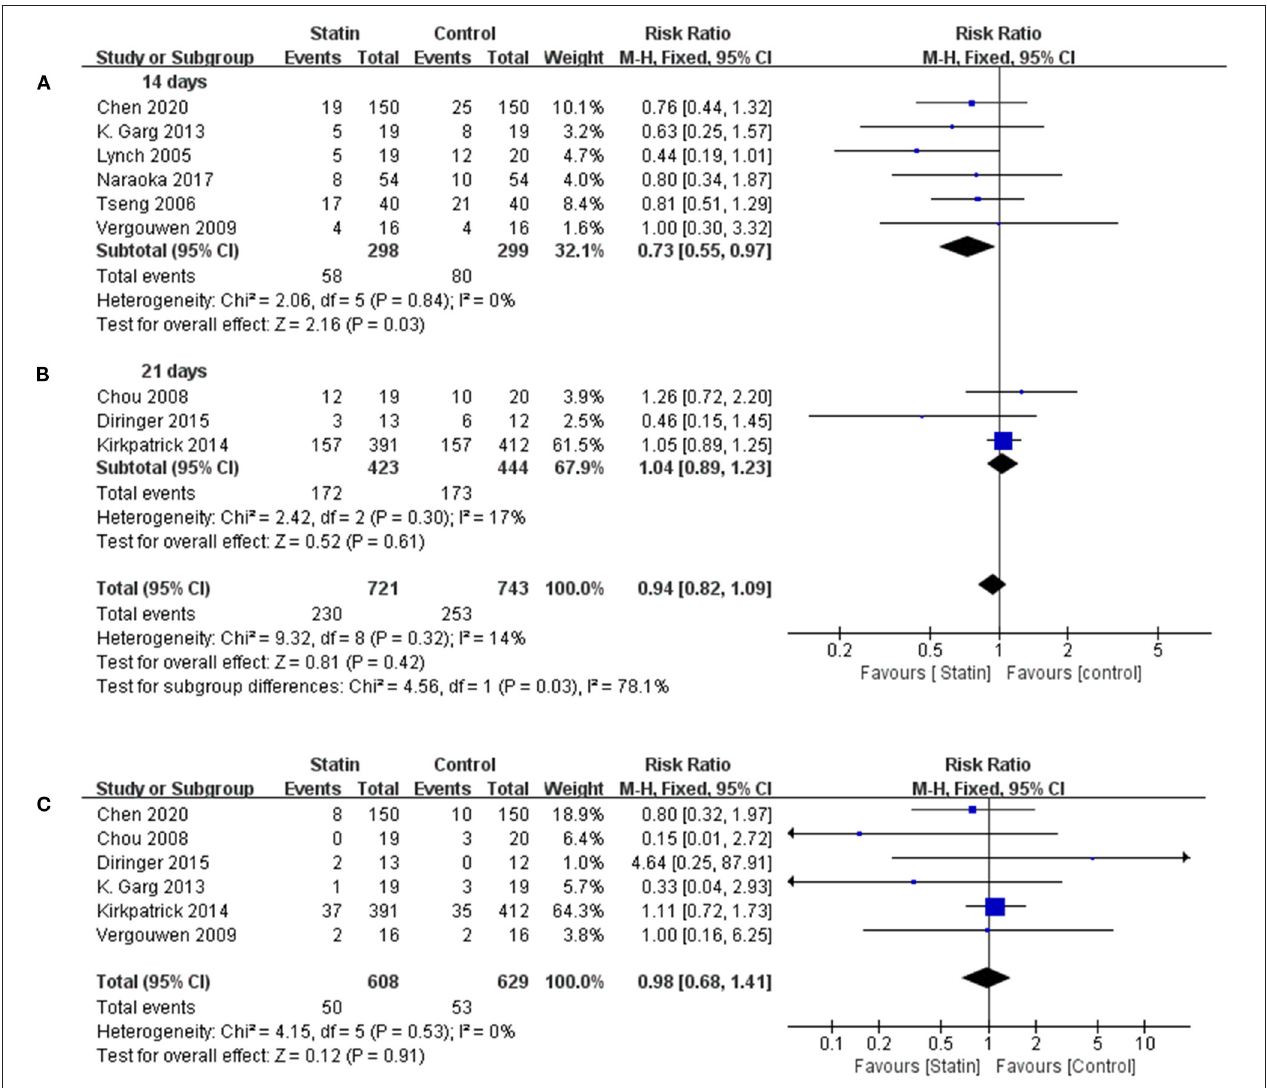
FIGURE 2 | Forest plot comparing the poor neurological prognosis for the course of 14 (A) and 21 days (B) respectively and all-cause mortality (C) between statin and placebo